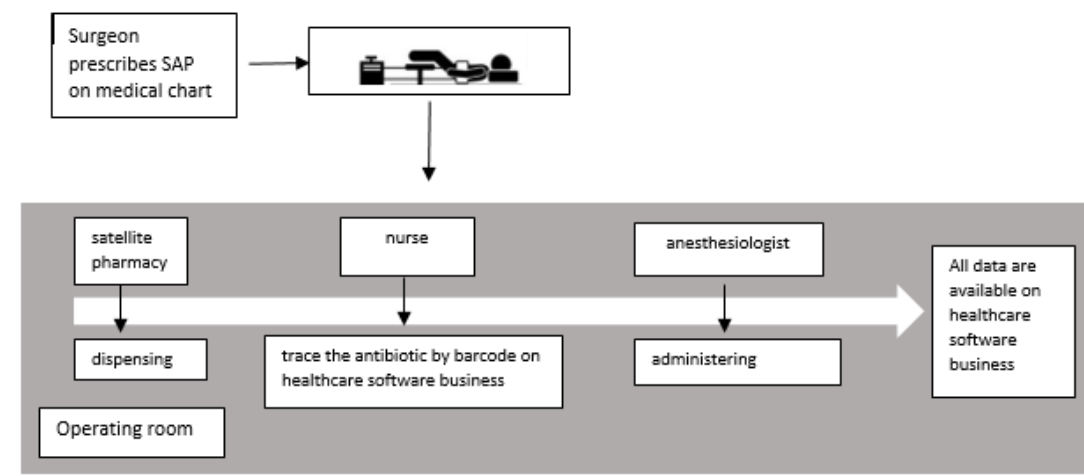
Figure 1. Workflow of ordering, dispensing, administering and documenting, defined by Terni hospital evidence-based guidelines for the optimal use of